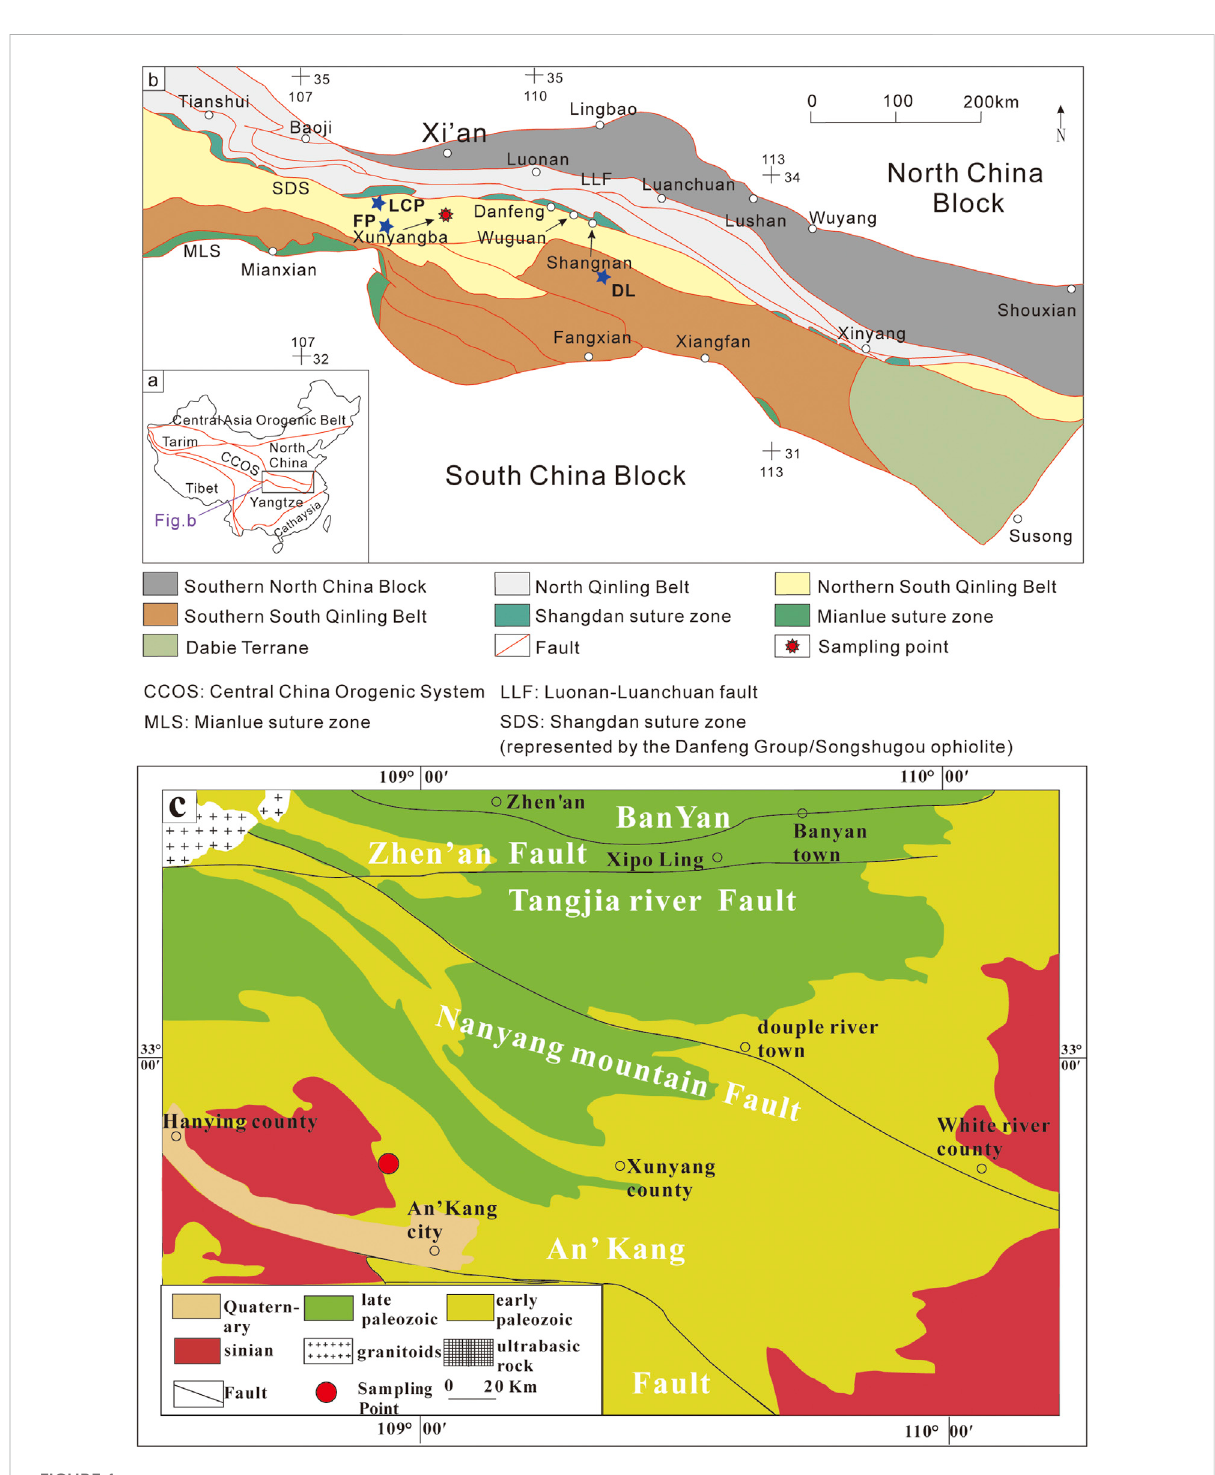
FIGURE 1 (A,B) TectonicframeworkofQinlingOrogenicBelt(afterDongetal.(2011b)modi fi ed).LCP-Longcaopinggroup,FP-Fopinggroup,DL-Douling group are from Zhang et al. (2001), (2021). (C) Tectonic framework of Xunyangba area (after Bai and Zhu (1984) modi fi